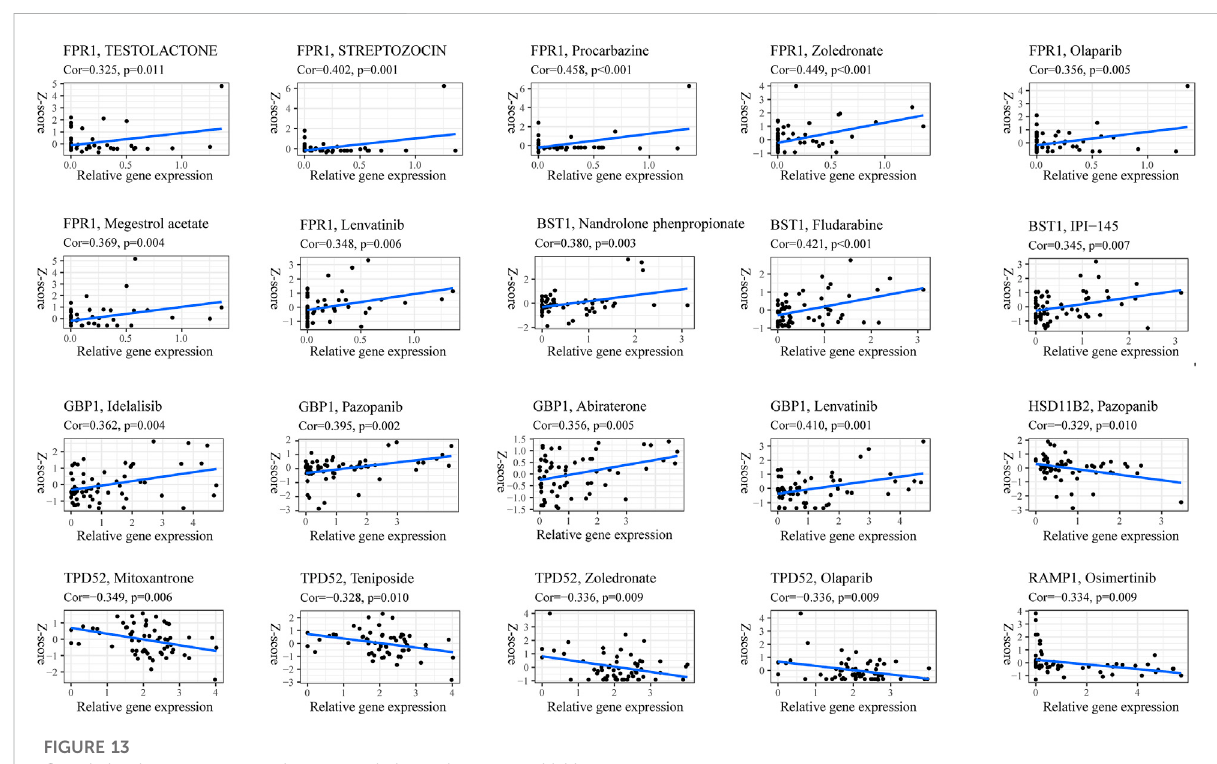
FIGURE 13 Correlation between pyroptosis score and chemotherapy